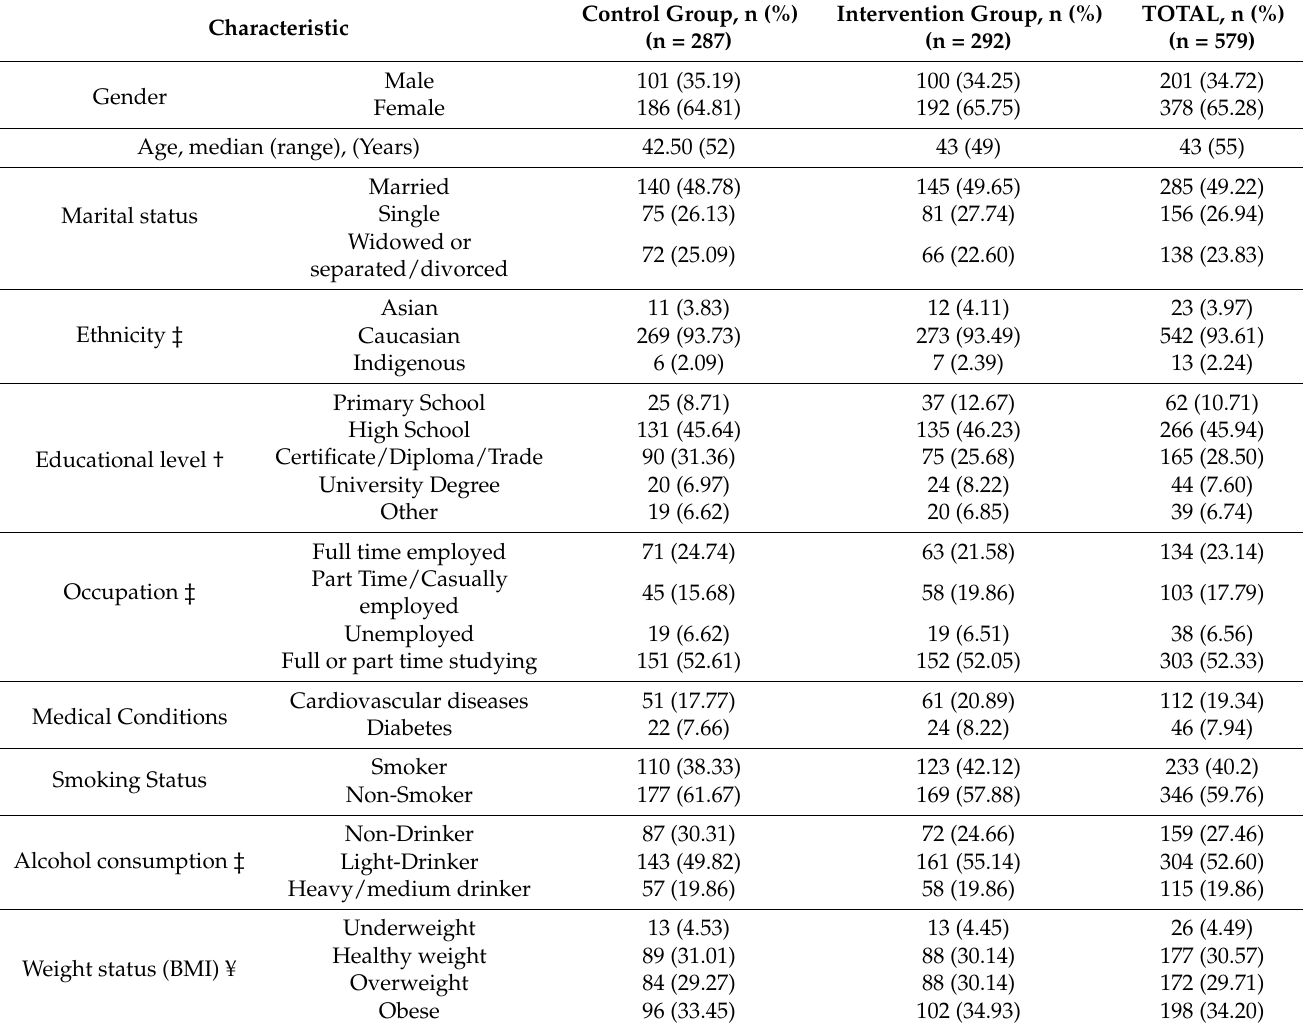
Table 1. Demographic and baseline characteristics of